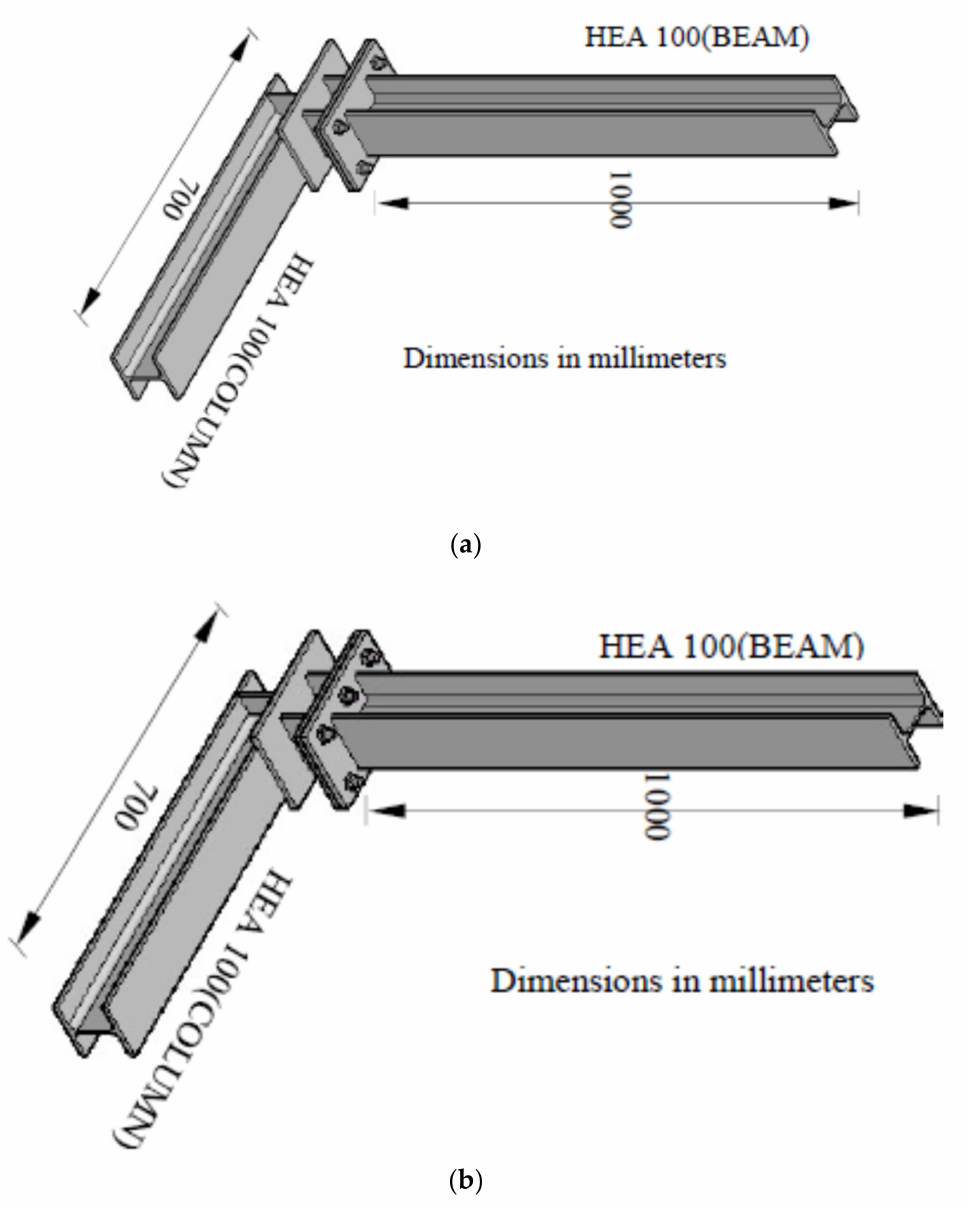
Figure 12. Three-dimensional schematic view of the investigated steel bolted joints: ( a ) JL-4 bolted joint specimen and ( b ) JL-6 bolted joint